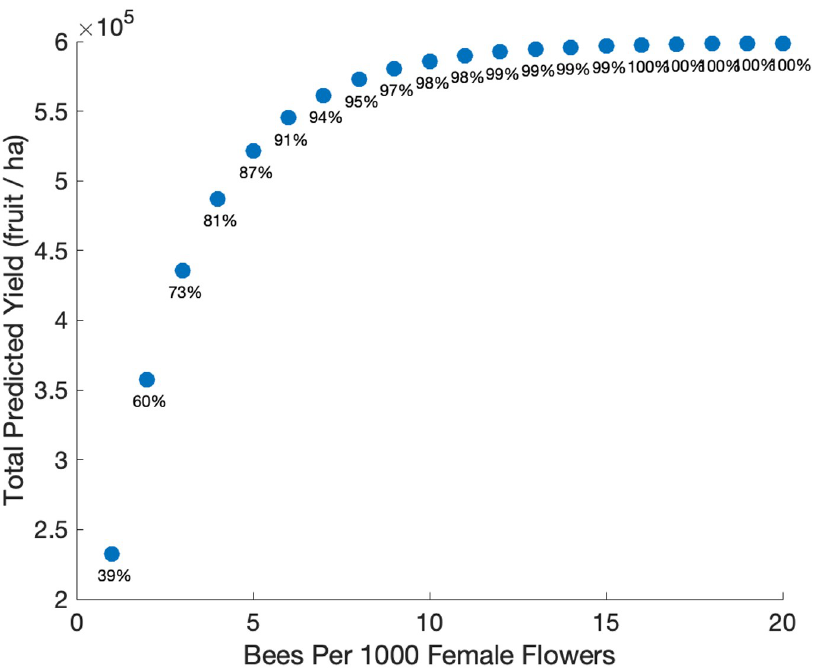
Fig 7. Total predicted yield as a function of the number of bees per 1000 female flowers. The bee density varies from 1 bee per 1000 female flowers to 20 bees per 1000 female flowers, and the total amount of buds was kept constant at 1.2 million/ha with a male to female flower ratio of 1:1. Other parameters are baseline values in Table 2. The percentage of open female flowers that achieved sufficient pollination to set fruit is listed under each data point.